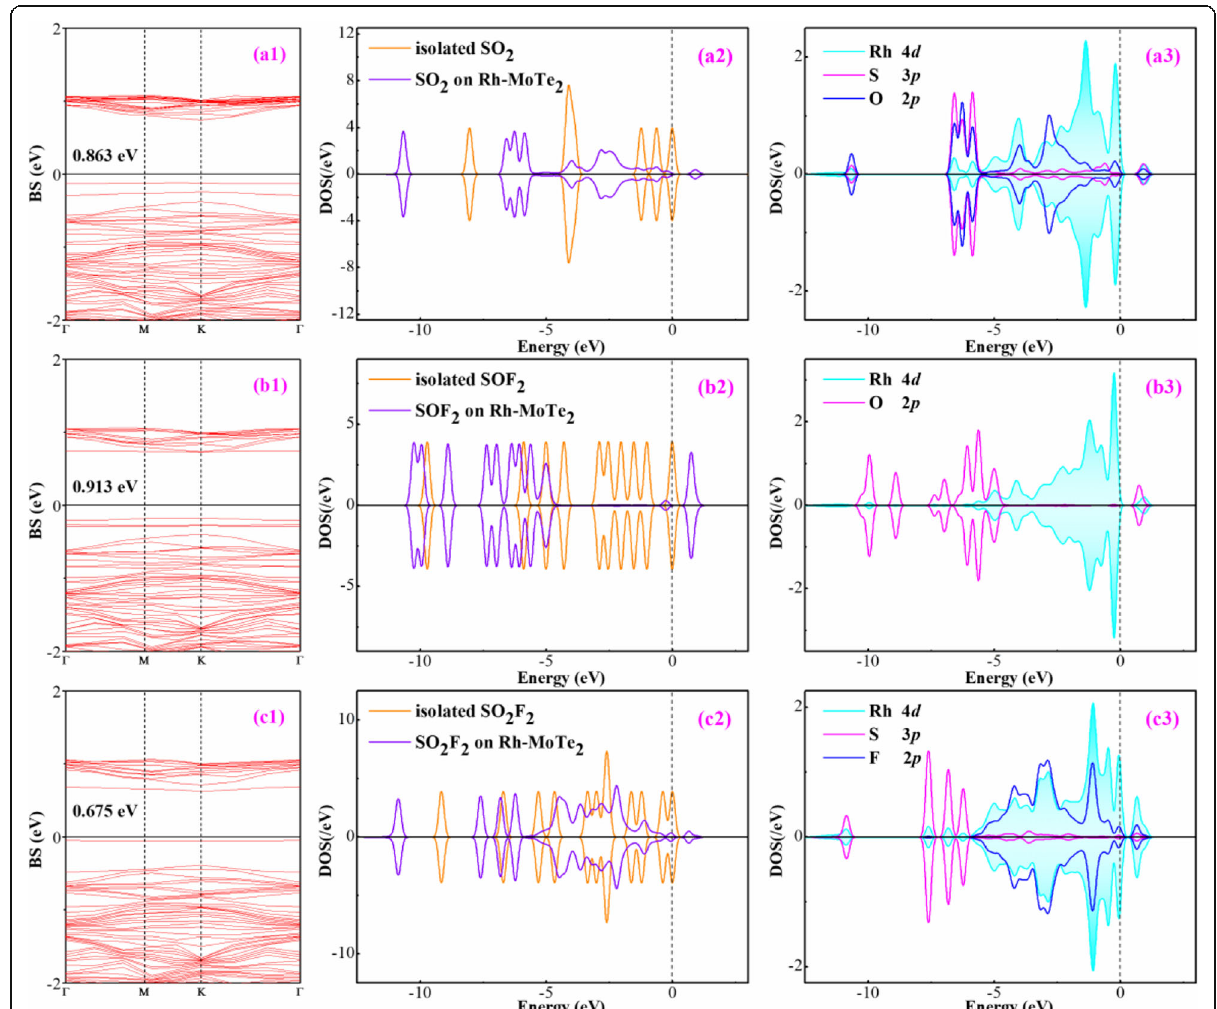
Fig. 6 BS and DOS of various systems. (a1) – (a3) SO 2 system; (b1) – (b3) SOF 2 system; and (c1) – (c3) SO 2 F 2 system. In DOS, the dash line is the Fermi